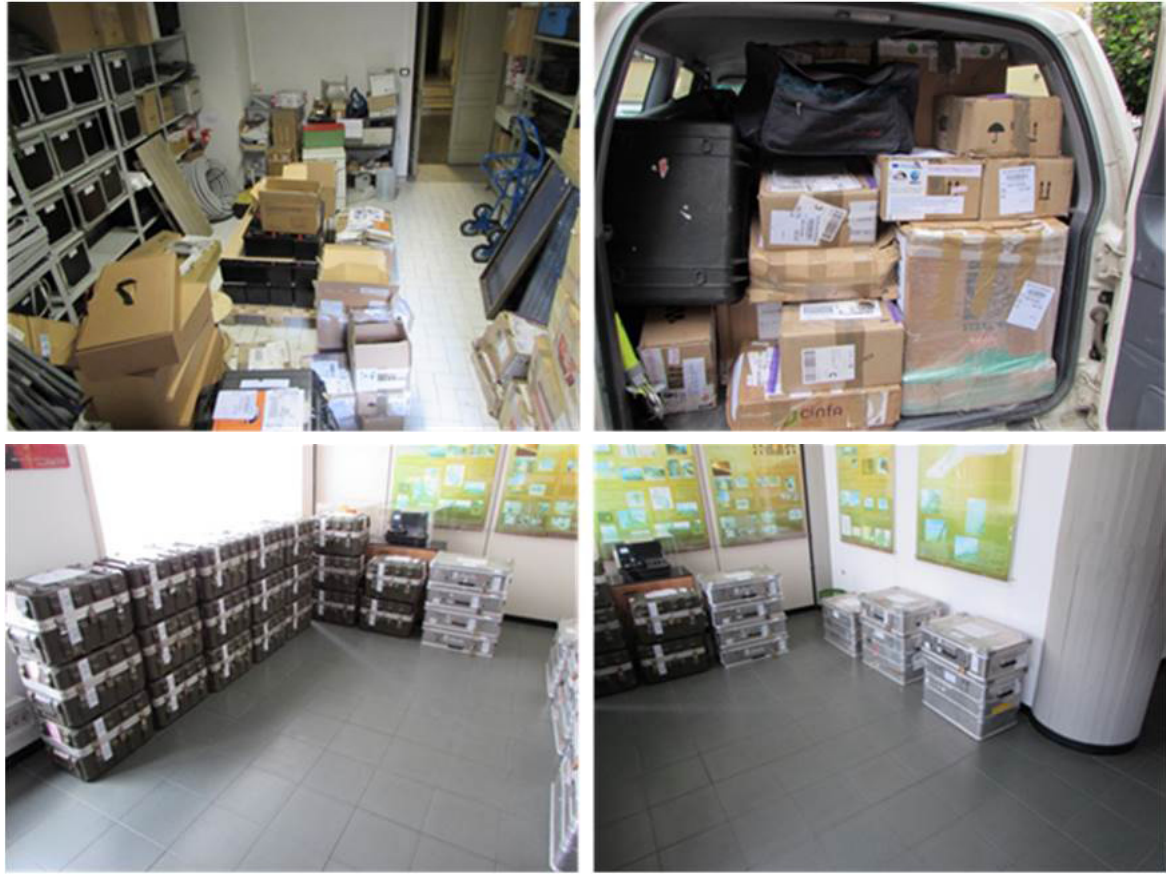
Figure 14. Transport and storage of the sensors of the portable seismic network before their deployment.